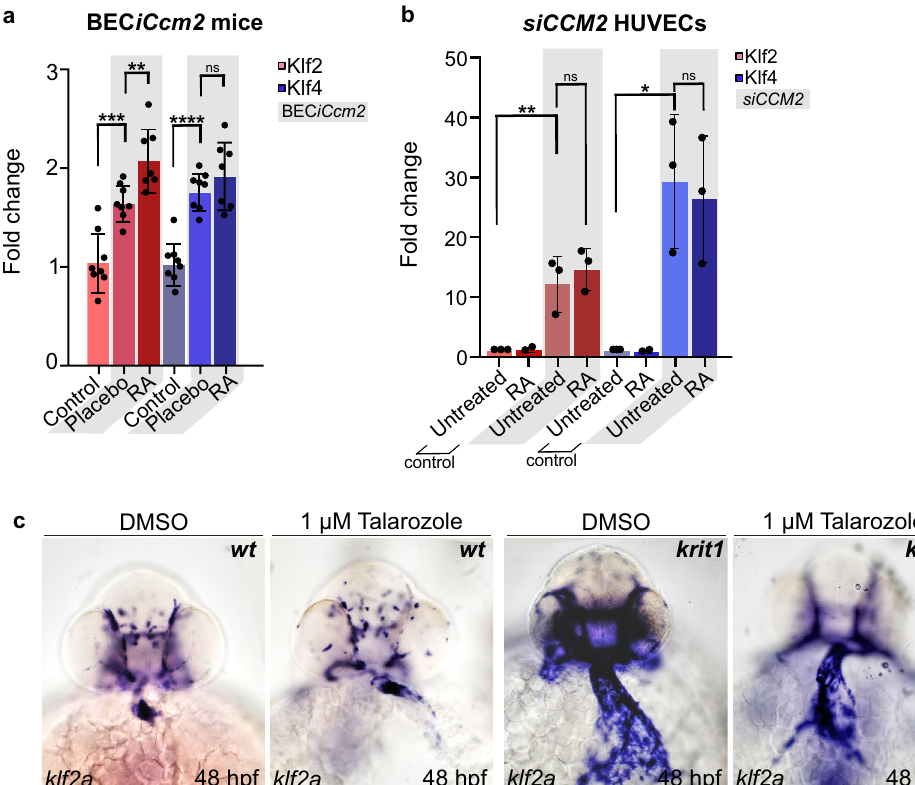
Figure 4. Assessment of KLF2/4 mRNA expression in treated animal models of CCM. (a ) Expression levels of treated BEC iCcm2 mouse cerebella after curative RA treatment (~ 20 mg/kg/day for 21 days) as mean fold changes determined by qRT-PCR. (ns = P > 0.05; **P < 0.01;***P < 0.001;****P < 0.0001 vs. control). Each data point represents one sample. Error bars show mean with SD. ( b ) Fold changes of KLF2/4 mRNA expression in siCCM2 -transfected HUVECs treated with RA for 48 h compared to untreated cells (*P < 0.05; **P < 0.01). Each data point represents one sample. ( c ) Whole-mount in situ hybridization of klf2a in 48 hpf zebrafish embryos treated with DMSO or